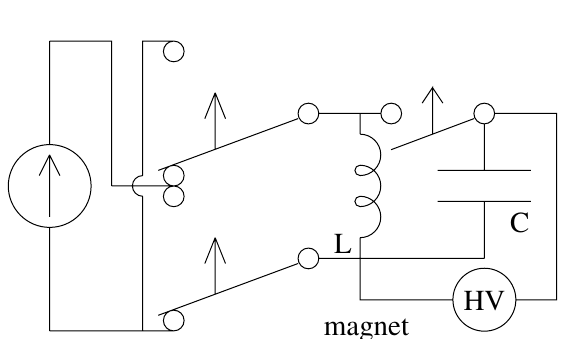
jump height of t (cid:1) 5 m at all interaction x;y